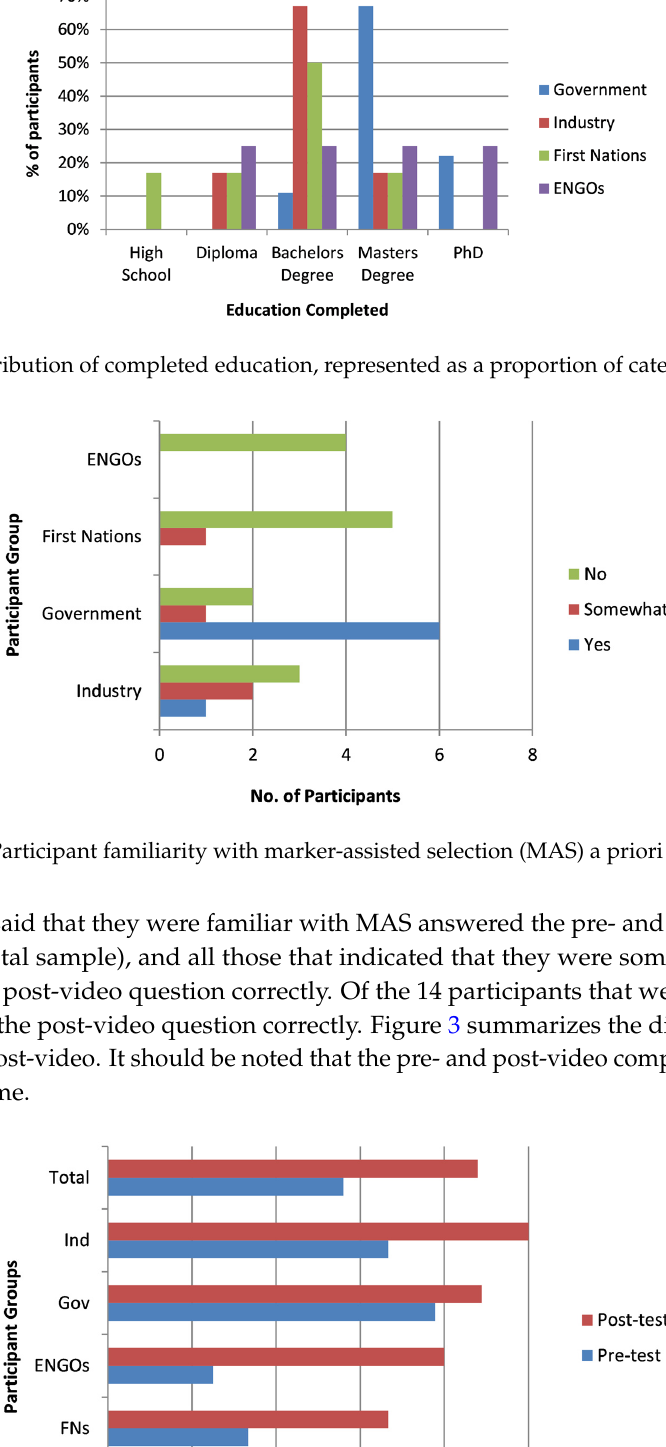
Figure 3. Distribution of correct answers to the pre- and post-video comprehension question, represented by proportion of categorized group. Ind, Industry; Gov, Government; FNs, First Nations.